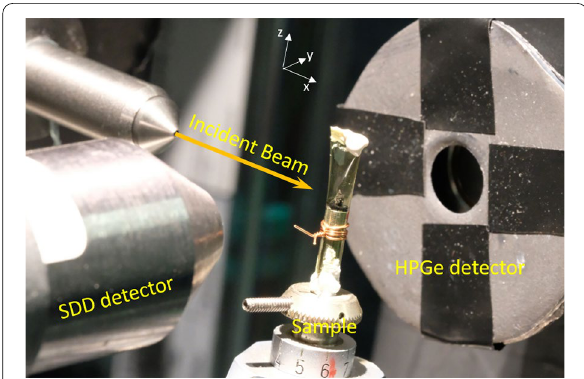
Fig. 1 Instrumental overview photograph of the setup as applied at beamline ID15A (ESRF, Grenoble, France) during the